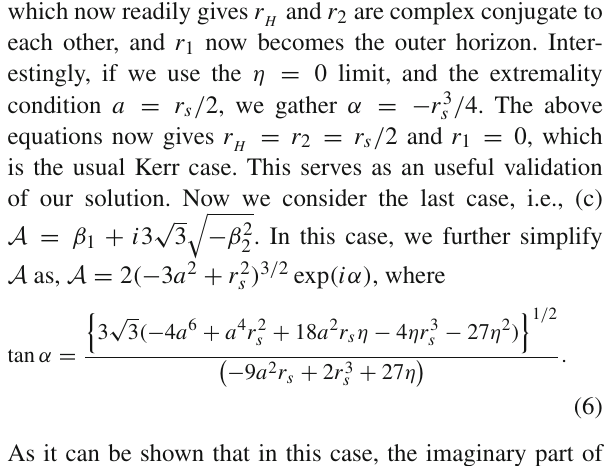
in Fig. 1. From this figure, we observe that for a specific η , at the same a , there can be different numbers of horizons or real ¯ (cid:2) roots to the solution of . For example, for η = 0, denoted by the solid red line and signifying zero deformation, there are two roots, and these two roots merge to a single one at the point a = 0 . 5 = r s / 2 in the extremal case. On the other hand, when η = 0 . 01 or η = 0 . 05, denoted by the dot-dashed blue and dotted green lines respectively, there can be three, two, or even one real roots to the solution for a fixed value of a